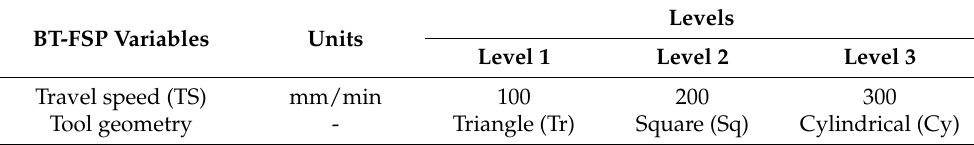
Table 2. The BT-FSP variables and their